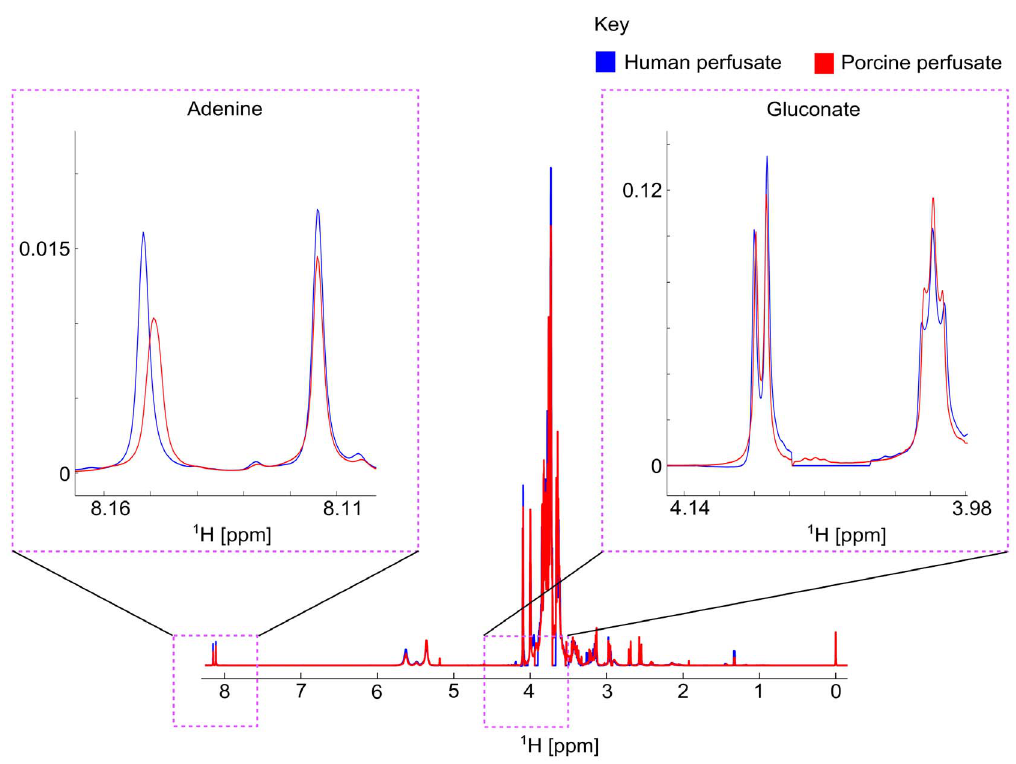
Fig. 2. 1 H-NMR spectral overlay plot demonstrating the similarity of HMP perfused pig (red) and human (blue) kidneys after 4 hours of perfusion.